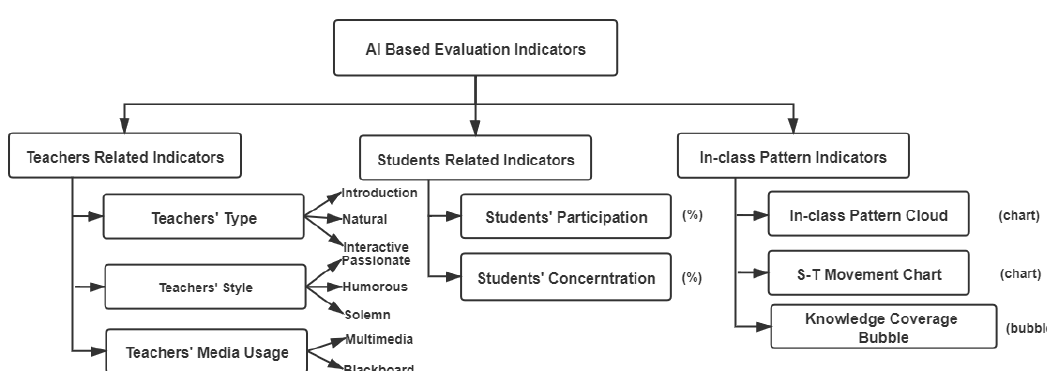
Figure 2. An AI (artificial intelligence)-based evaluation index system.